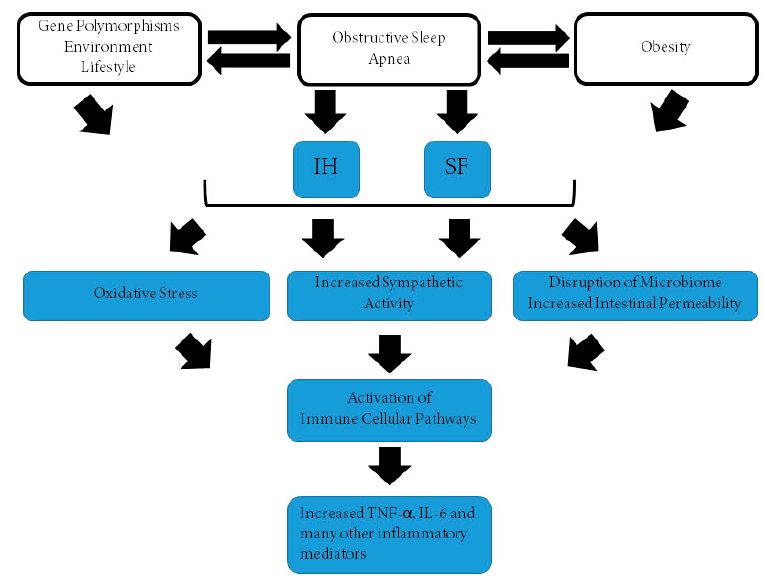
Figure 1. Schematic diagram illustrating the putative interactions between obstructive sleep apnea, obesity, and both genetic, environmental, and lifestyle factors, ultimately leading to a cascade of pathophysiological pathways that result in increased systemic inflammation as illustrated by increased levels of TNF- α and IL-6. Table 1. Summary of published studies examining TNF- α serum concentrations in adults and children with obstructive sleep apnea syndrome (OSAS) over the last 15 years. Green rows indicate significant findings, orange rows indicate negative findings, and yellow rows reflect equivocal results.